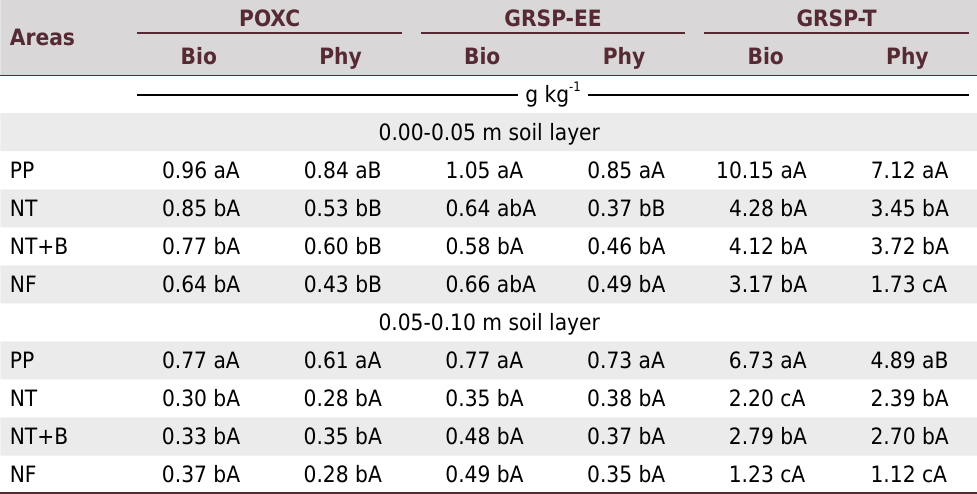
Table 4. Labile organic carbon (POXC), easily extractable glomalin (GRSP-EE) and total glomalin (GRSP-T) of biogenic (Bio) and physicogenic (Phy) aggregates from areas under management systems in the subtropical region of Brazil